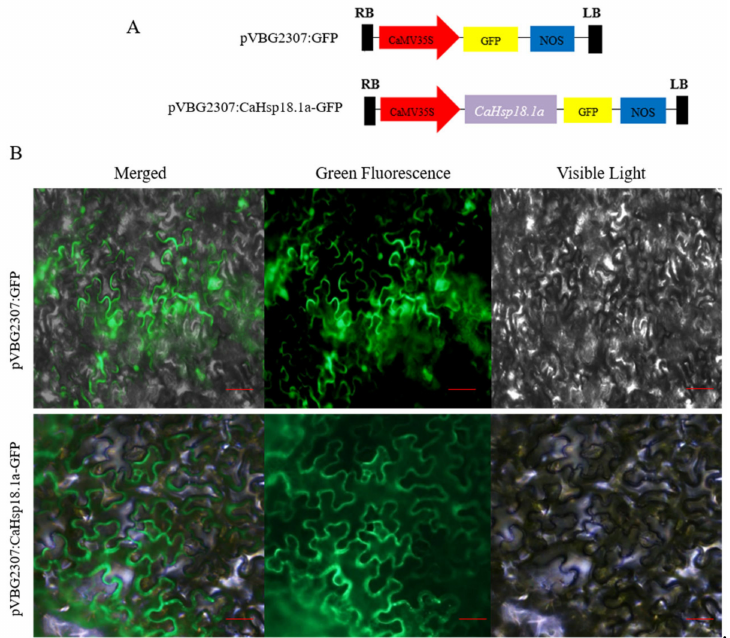
Figure 2. Transient expression of CaHSP18.1a in tobacco. ( A ) Schematic diagram of the CaHSP18.1a subcellular localization expression vector. ( B ) Subcellular localization of the CaHSP18.1a protein in tobacco leaves, with pVBG2307: GFP as control. Scale bar = 50 µ